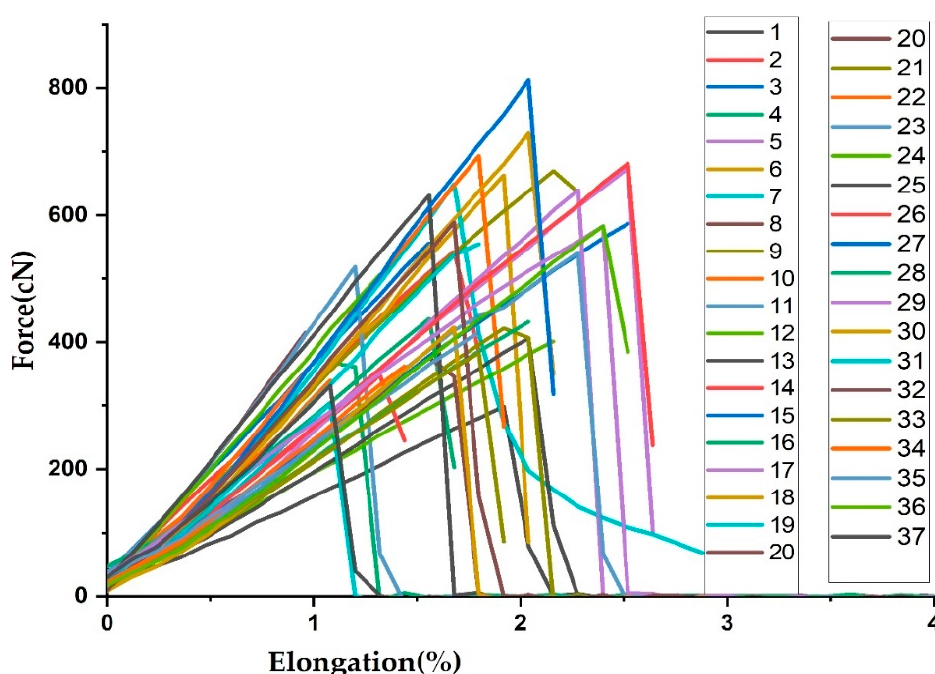
Figure 6. Force versus élongation cuves.